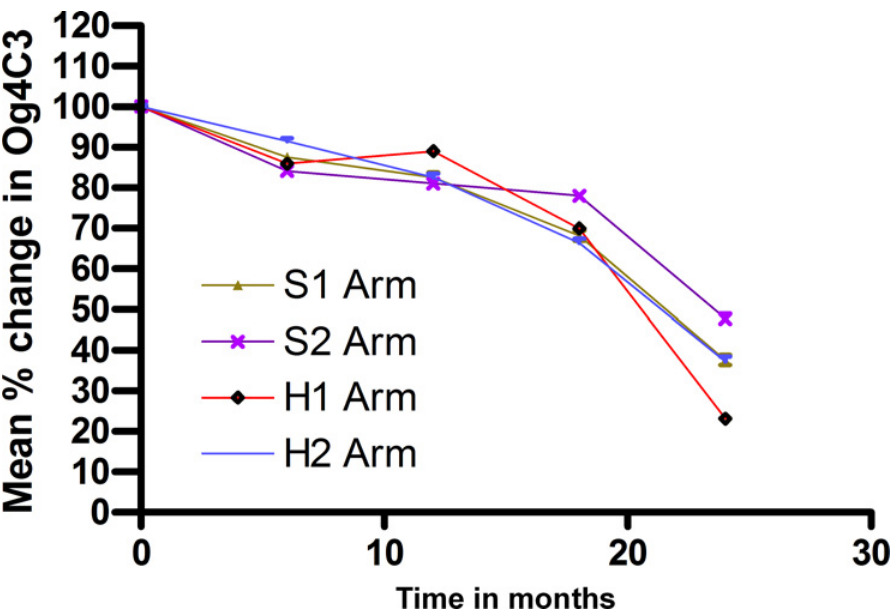
Fig 2. Mean percentage reduction on OG 4 C 3 antigen levels compared to baseline. Percentage changes from baseline values for individuals were calculated at each follow-up point and then means for each treatment group derived.